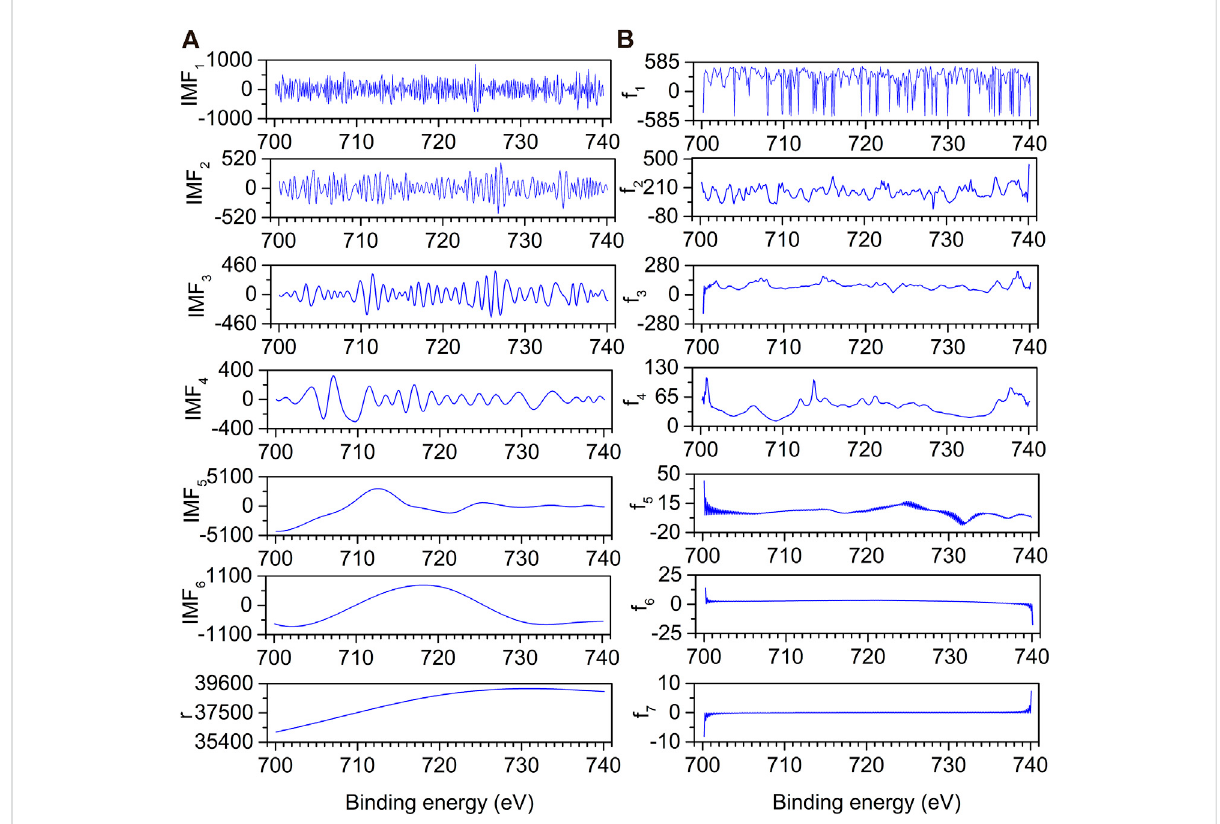
FIGURE 9 EMD decomposition results (A) and their corresponding instantaneous frequencies (B) for XPS spectrum.